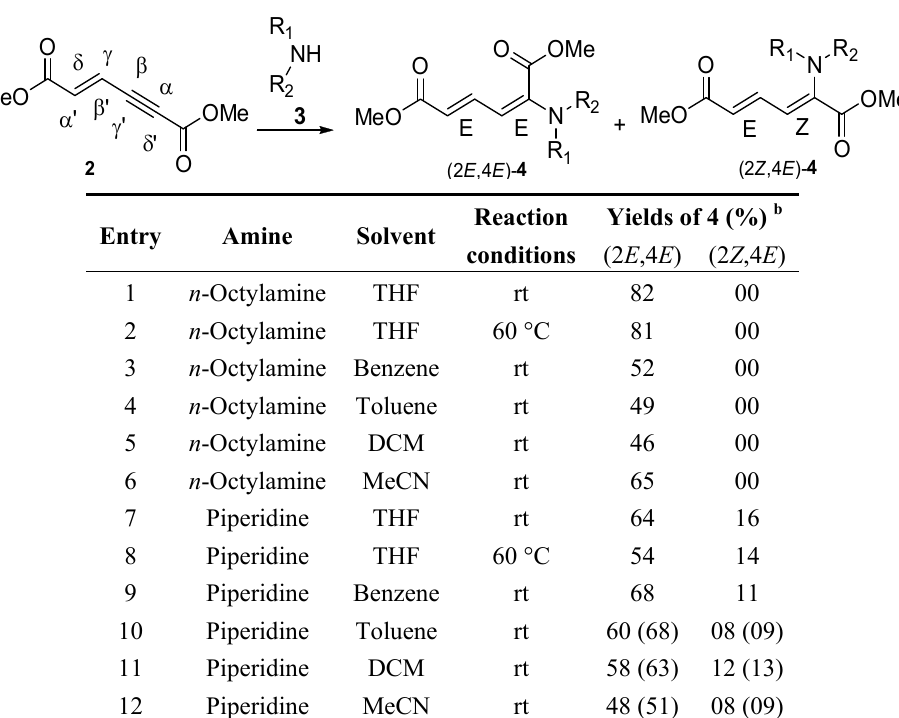
Table 1. Optimization of reaction conditions a